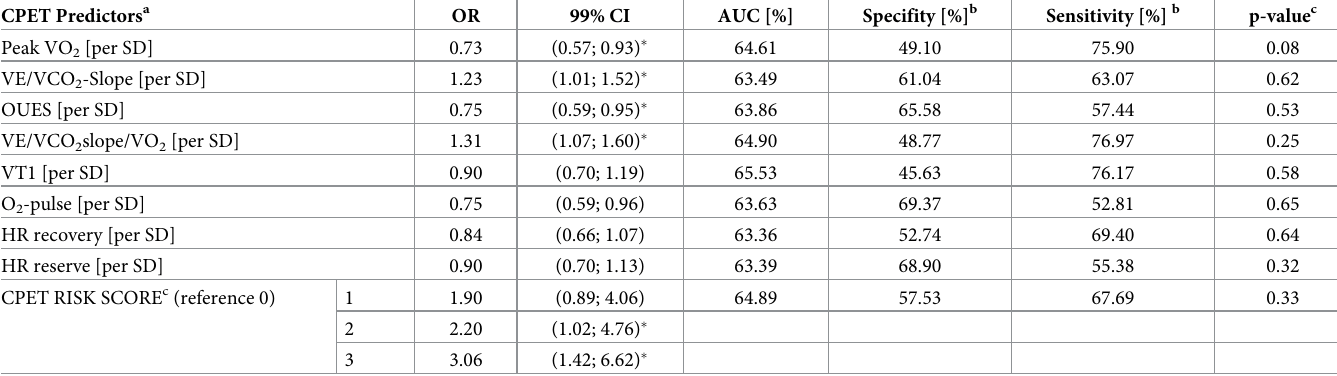
Table 2. Multiple logistic mixed models for major adverse cardiac